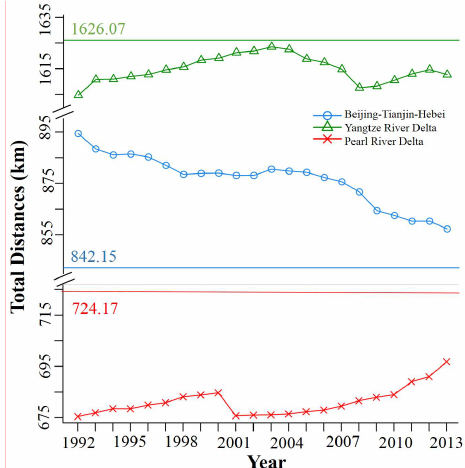
Figure 5. Total distance (Gravity Distance) between the Gravity Center of the megaregion and the Gravity center of internal cities for the three megaregions from 1992 to 2013. The straight lines and corresponding values mean the total distance (Geometric Distance) between the Geometric Center of megaregion and the Geometric Center of inner cities for the three megaregions in